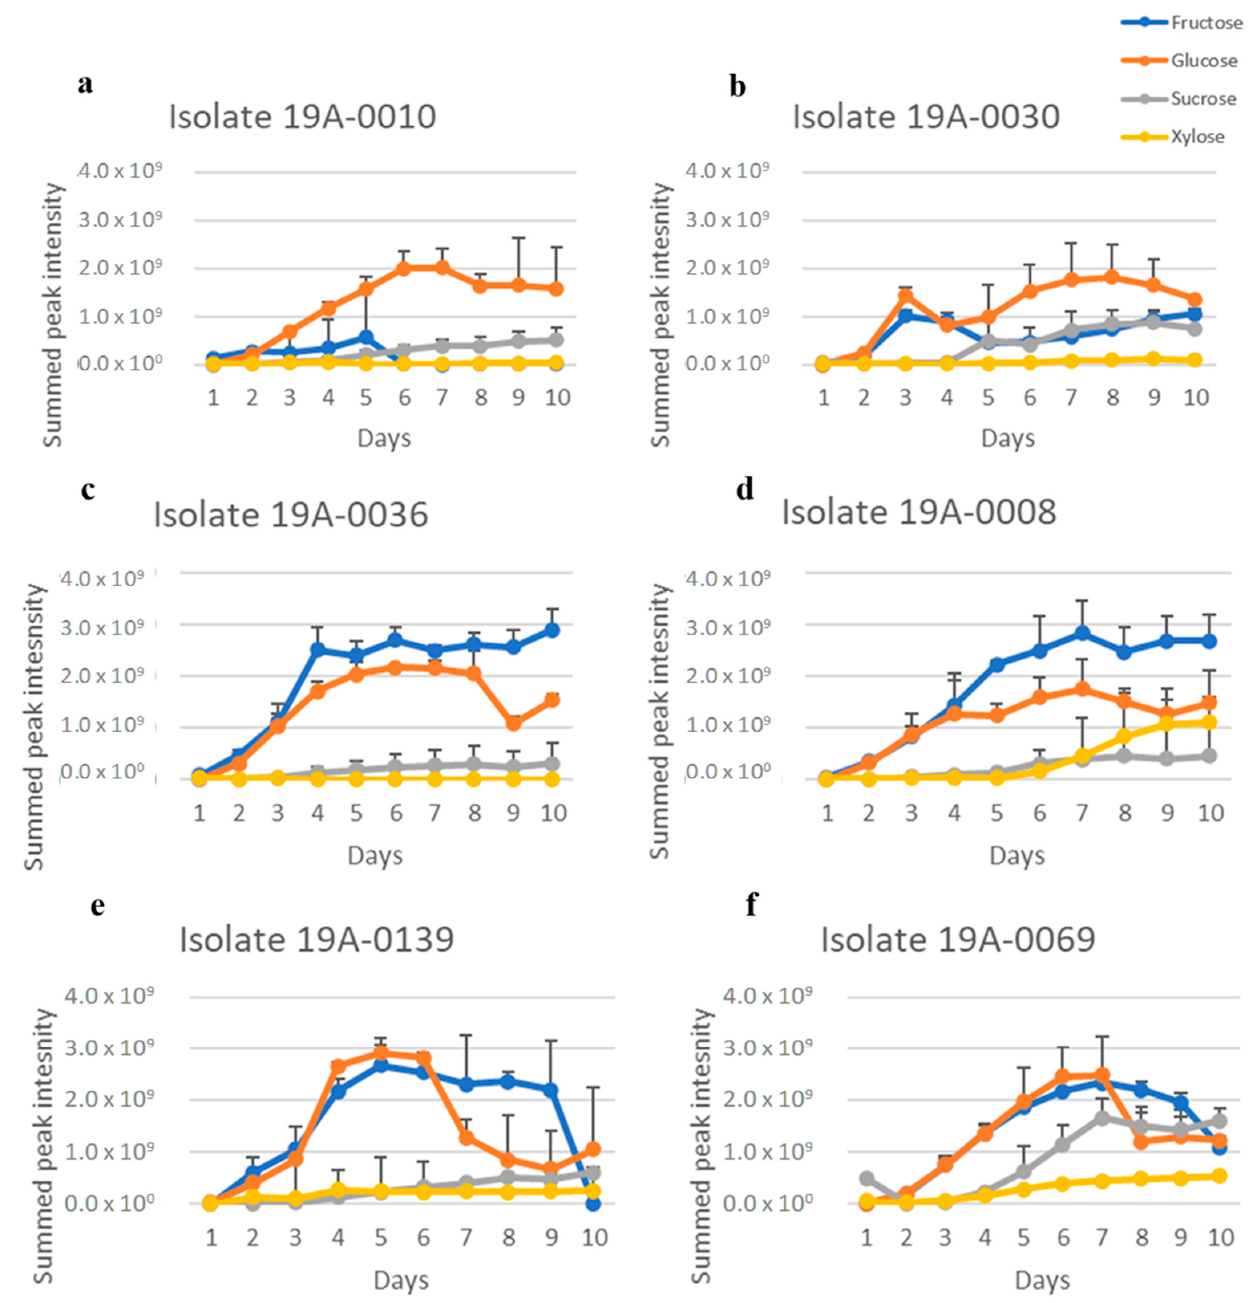
Figure 6. Ethanol production of R. stolonifer isolates in the presence of glucose, fructose, sucrose, or xylose, along with asparagine as a nitrogen source. Data presented are the relative concentration of ethanol (as determined from NMR) with standard deviation (error bars), n = 3. ( a ) Isolate 19A–0010, ( b ) isolate 19A–0030, ( c ) isolate 19A–0036, ( d ) isolate 19A–0008, ( e ) isolate 19A–0139, ( f ) isolate 19A– 0069.